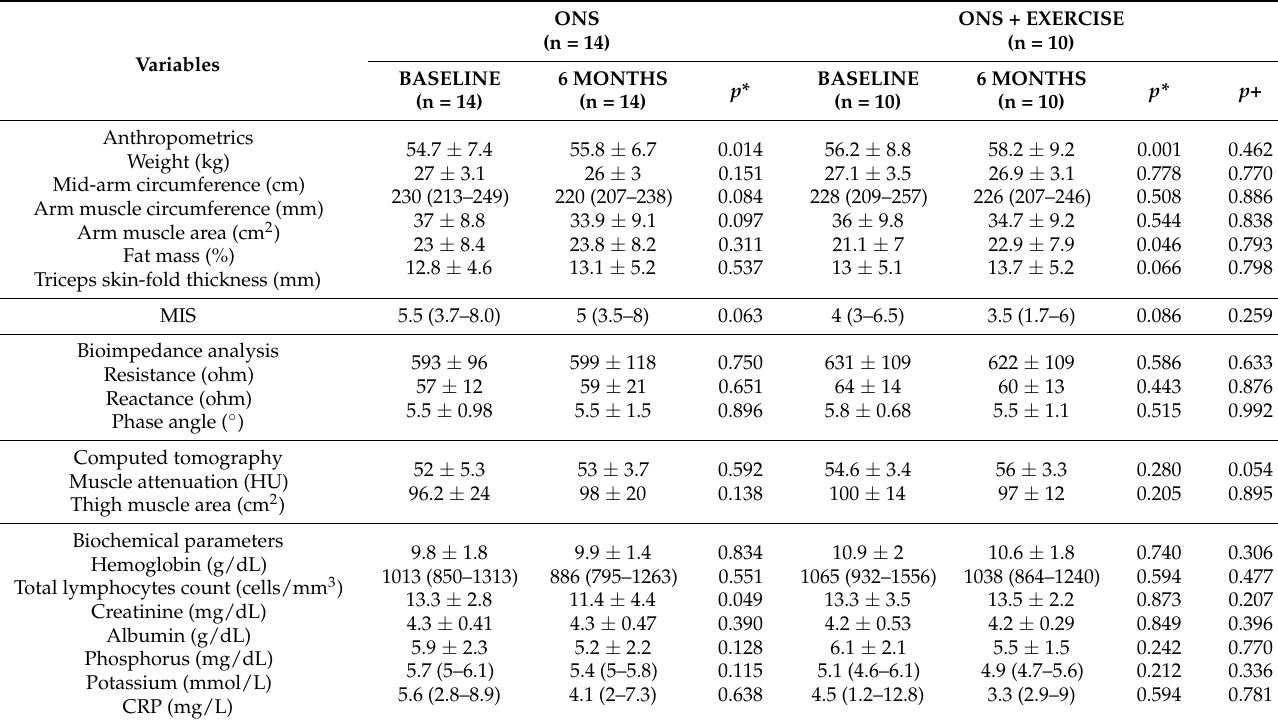
Table 2. Changes in anthropometrics, nutrition status, body composition, and blood